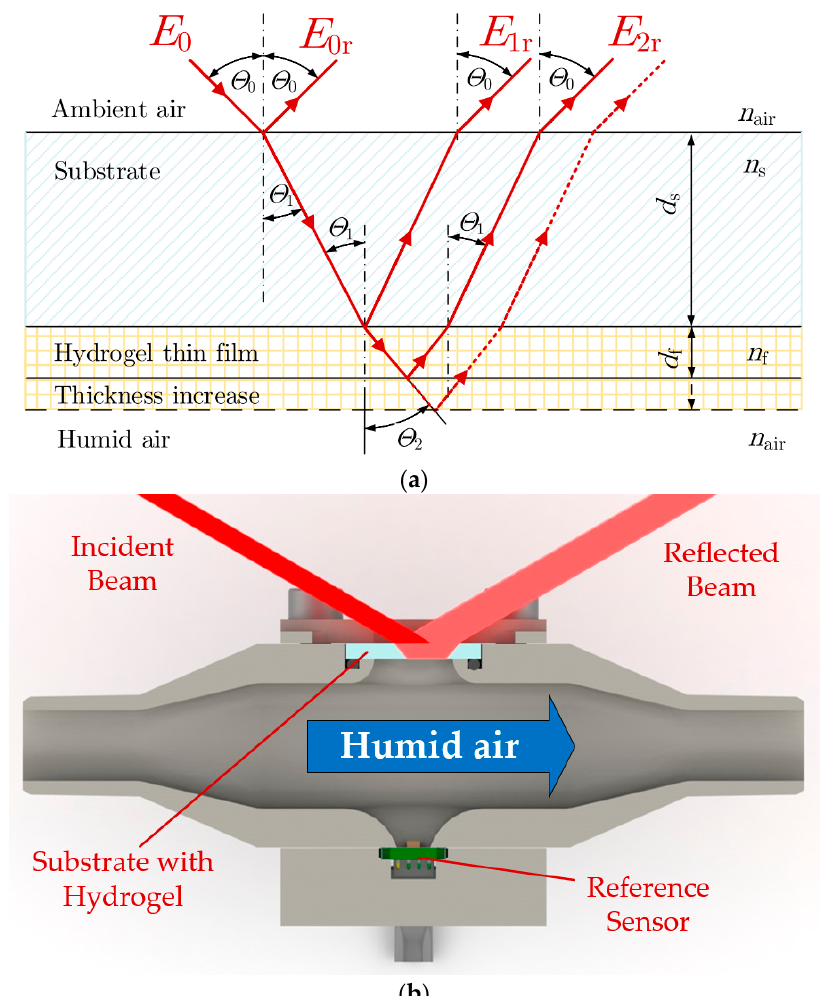
Figure 1. ( a ) Principal sketch of a field that gets reflected at a swelling hydrogel thin-film layer deposited on a substrate (thickness of the hydrogel is drawn exaggerated) and ( b ) sectional view of the practical implementation of the substrate with the hydrogel (drawn in light blue) on the measurement chamber. Reference sensor (in green) on the opposite